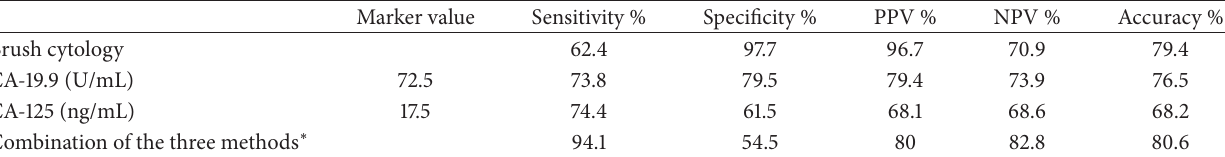
Table 2: Diagnostic performance of CA19-9, CA 125, brush cytology, and combination of three methods.